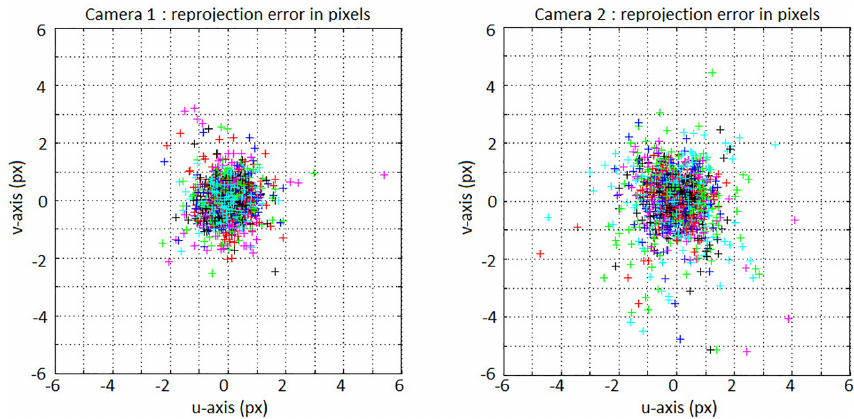
Figure 8. For each view and each chessboard corner (which represents an amount of 30 × 48 points), difference between corner position on the image, and corner position computed by re-projection, using OcamCalib calibration